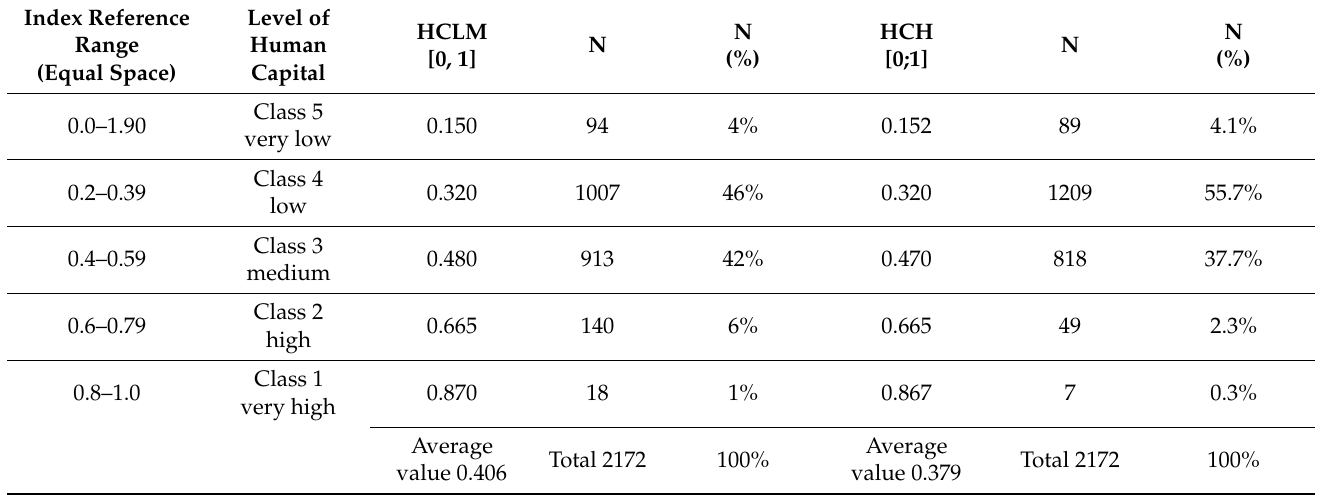
Table 5. HCH and HCLM—basic characteristics for communes in each class in terms of level of human